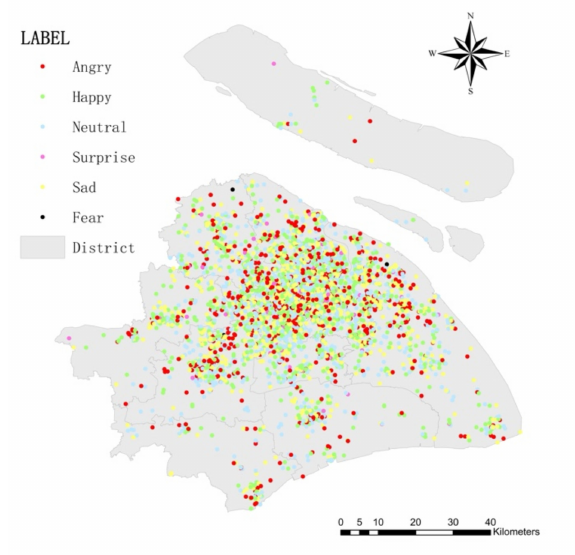
Figure 7. Sentiment classification distribution. Table 4. Results of sentiment